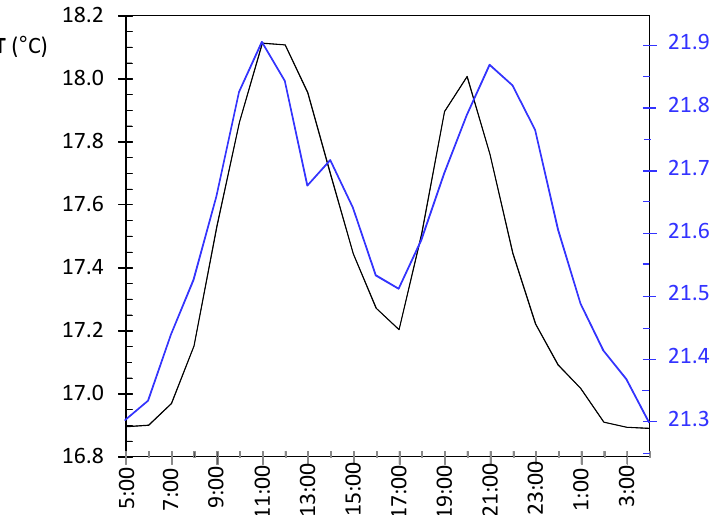
Figure 10. Daily evolution of temperature for node LO3 (black trajectory), averaged from 5 December until 2 February (values in ◦ C indicated on the left scale), and for node CH2 (blue trajectory), averaged from 11 December until 2 January 2018 (values on the right scale).